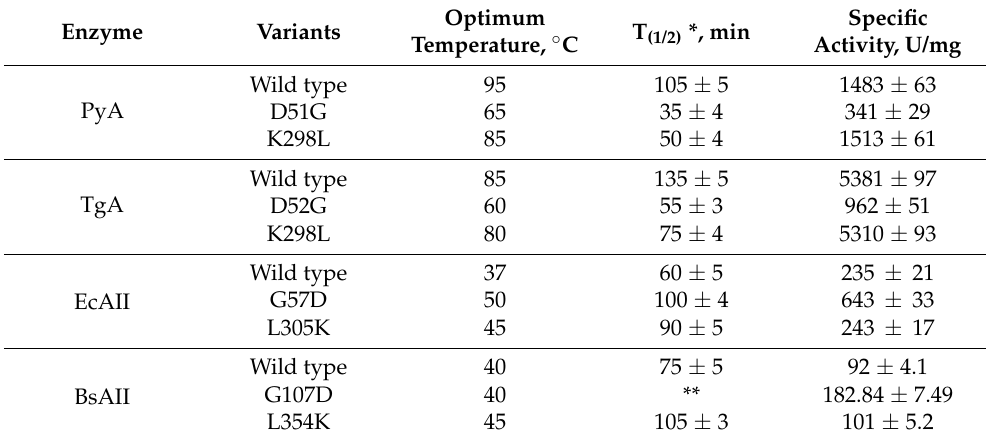
Table 2. Amino acid residues affected thermoactivity and thermostability of thermo-ASNases [59,98]. Specific Optimum T (1/2) *, min Enzyme Variants Activity, U/mg Temperature, ◦ C Wild type 95 105 ± 5 1483 ± 63 PyA D51G 65 35 ± 4 341 ± 29 K298L 85 50 ± 4 1513 ± 61 Wild type 85 135 ± 5 5381 ± 97 TgA D52G 60 55 ± 3 962 ± 51 K298L 80 75 ± 4 5310 ± 93 Wild type 37 60 ± 5 235 ± 21 G57D 50 100 ± 4 643 ± 33 EcAII L305K 45 90 ± 5 243 ± 17 Wild type 40 75 ± 5 92 ± 4.1 G107D 40 ** 182.84 ± 7.49 BsAII L354K 45 105 ± 3 101 ±